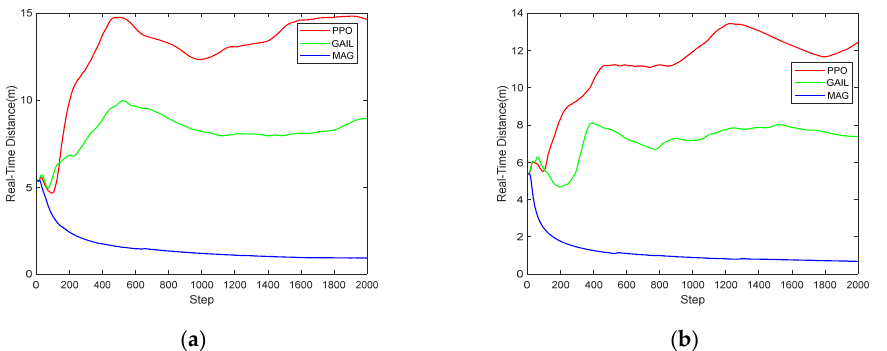
Figure 9. Real-Time distance between the AUV and target training 20,000 times in Scenes 1 and 2: ( a ) in Scene 1 and ( b ) in Scene 2.